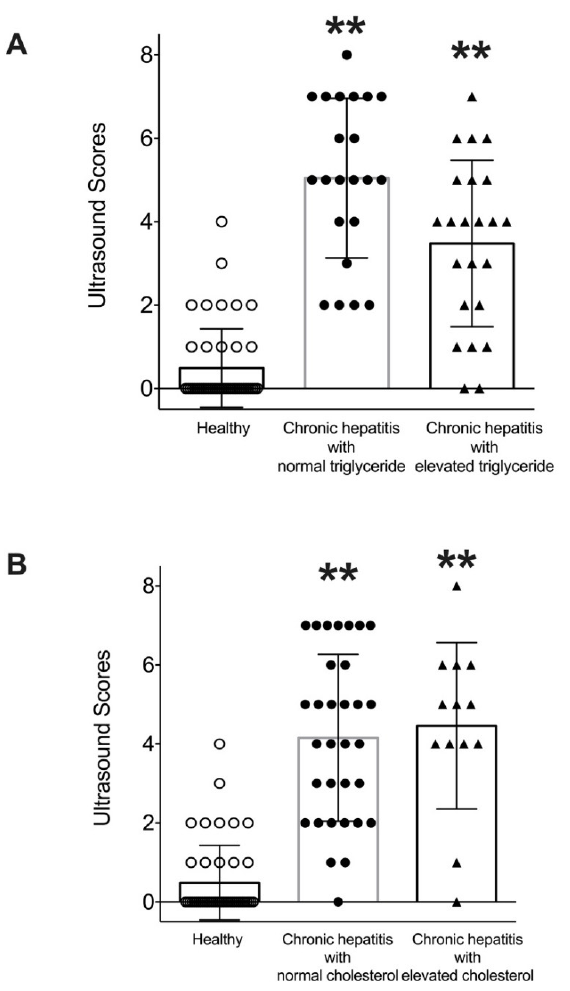
Figure 6. Scatterplots of ultrasound scores of healthy dogs and dogs with chronic hepatitis, classified by triglyceride ( A ) or cholesterol levels ( B ). Dots represent the ultrasound score for individual dogs, and lines represent mean ± SD. ** p < 0.01 vs. healthy.